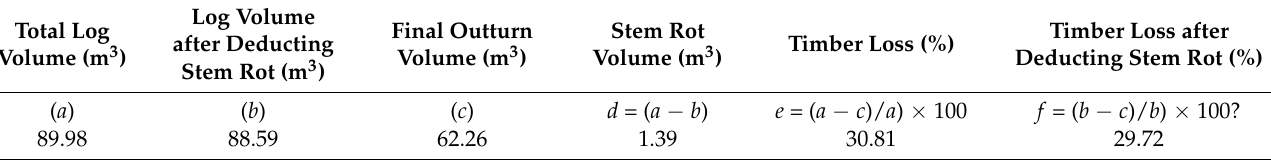
Table 4. Volumes of actual felled logs, final outturn, stem rot, and timber loss.